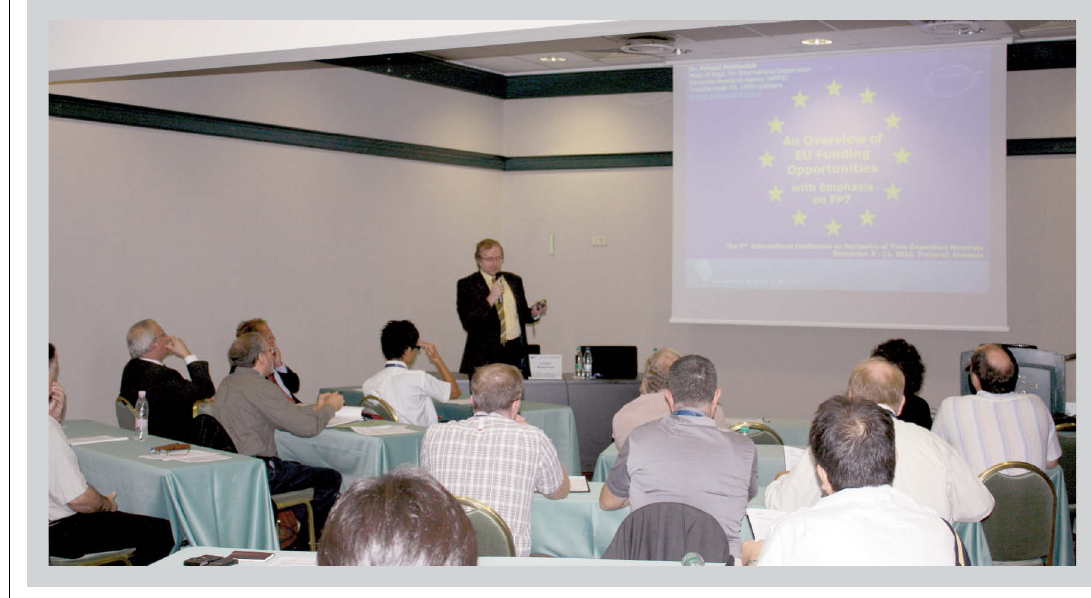
Figure 1: Discussion on possible colla- boration within The 7th European Framework Rese- arch Program. Introduction by Primoz